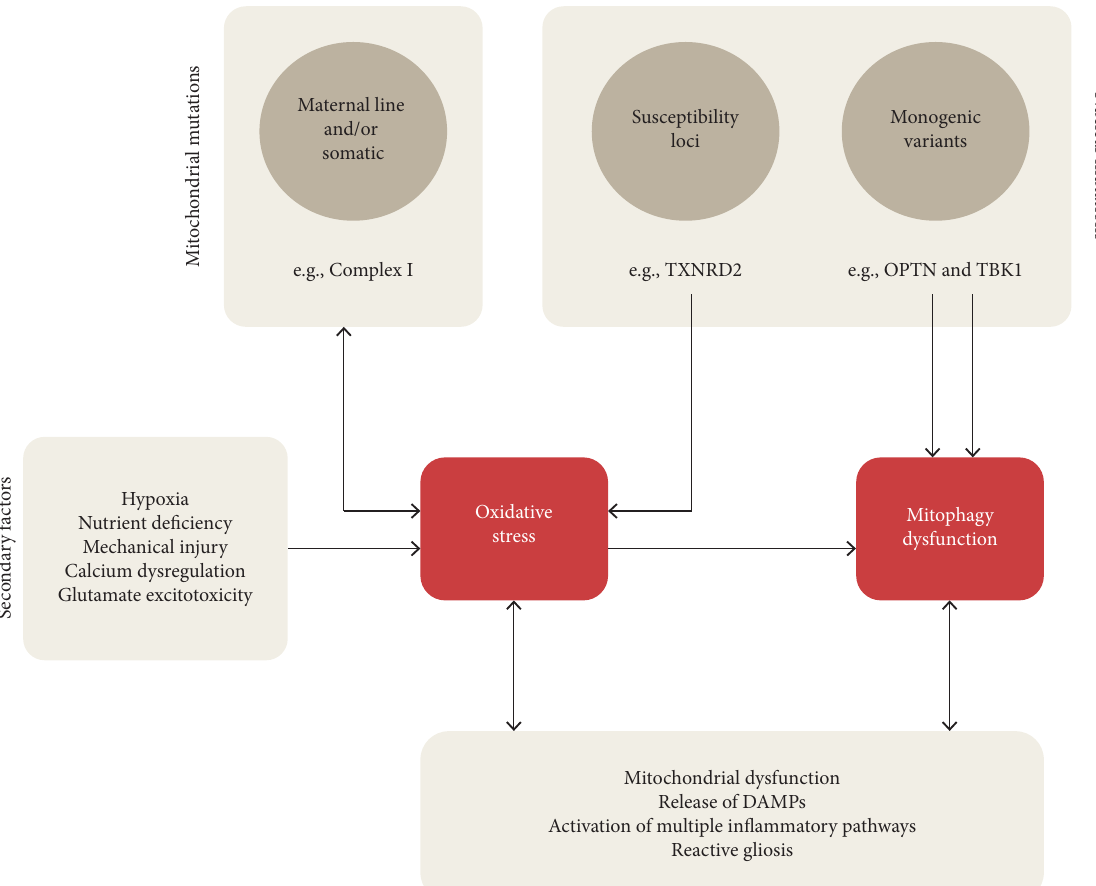
Figure 1: Mechanisms of mitochondrial dysfunction in retinal ganglion cells (RGCs). Mutations in mitochondrial and nuclear genomes can cause mitochondrial dysfunction via oxidative stress or defective mitophagy. Oxidative stress can also be generated through secondary causes external to the mitochondria, such as hypoxia. Mitochondrial-derived components can act as damage-associated molecular patterns (DAMPs) and trigger multiple inflammatory pathways that cause reactive gliosis and RGC